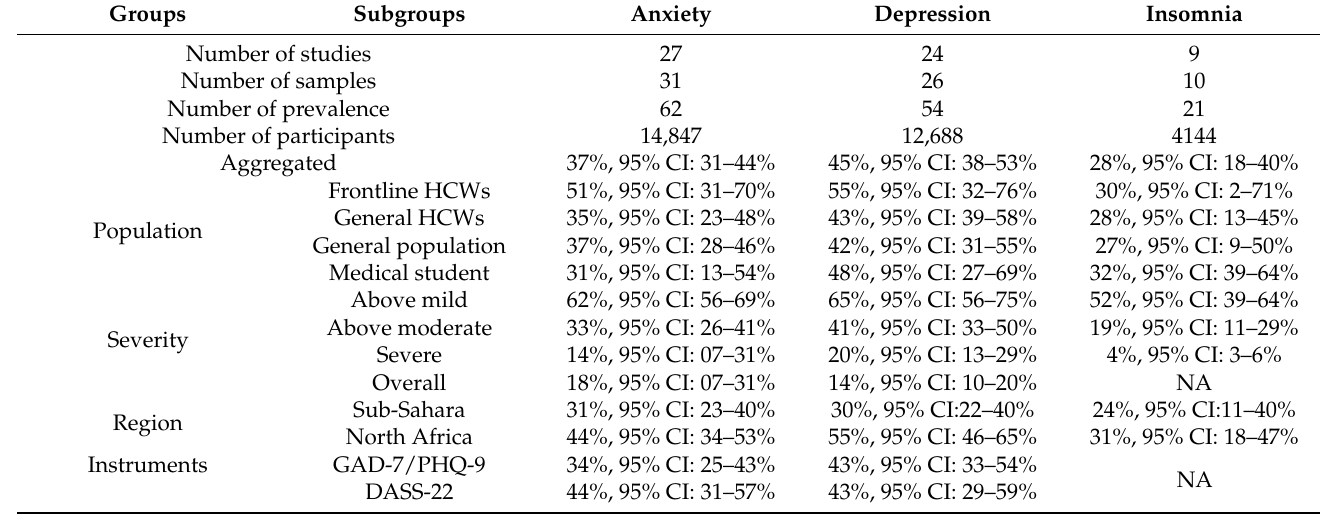
Table A2. Subgroup analyses of the prevalence of anxiety, depression, and insomnia.